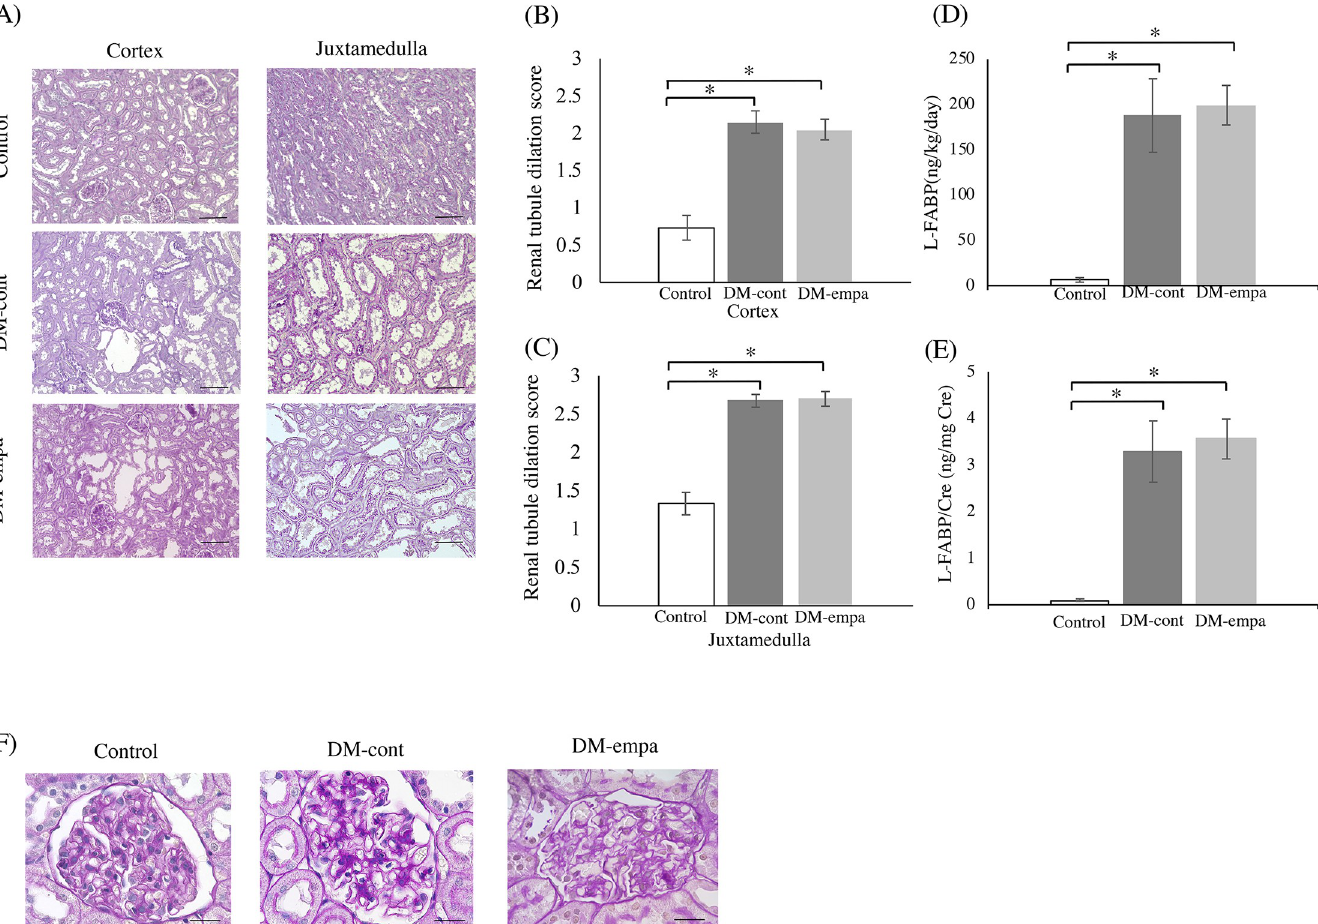
Fig 4. Assessment of renal histology and renal tubule dilation scores and urinary excretion of L-FABP after empagliflozin treatment. (A) Histology of the renal cortex and juxtamedulla. Sections were stained with PAS stain. Scale bar: 100 μ m. Renal tubule dilation scores of the cortex (B) and juxtamedulla (C). Urinary excretion of L-FABP for 24 hours (D, relative to body weight; E, relative to creatinine excretion). � p < 0.05 vs Control. (F) Typical glomerular structure of control, DM-cont and DM-empa. Sections were stained with PAS stain. Scale bar: 20 μ m.